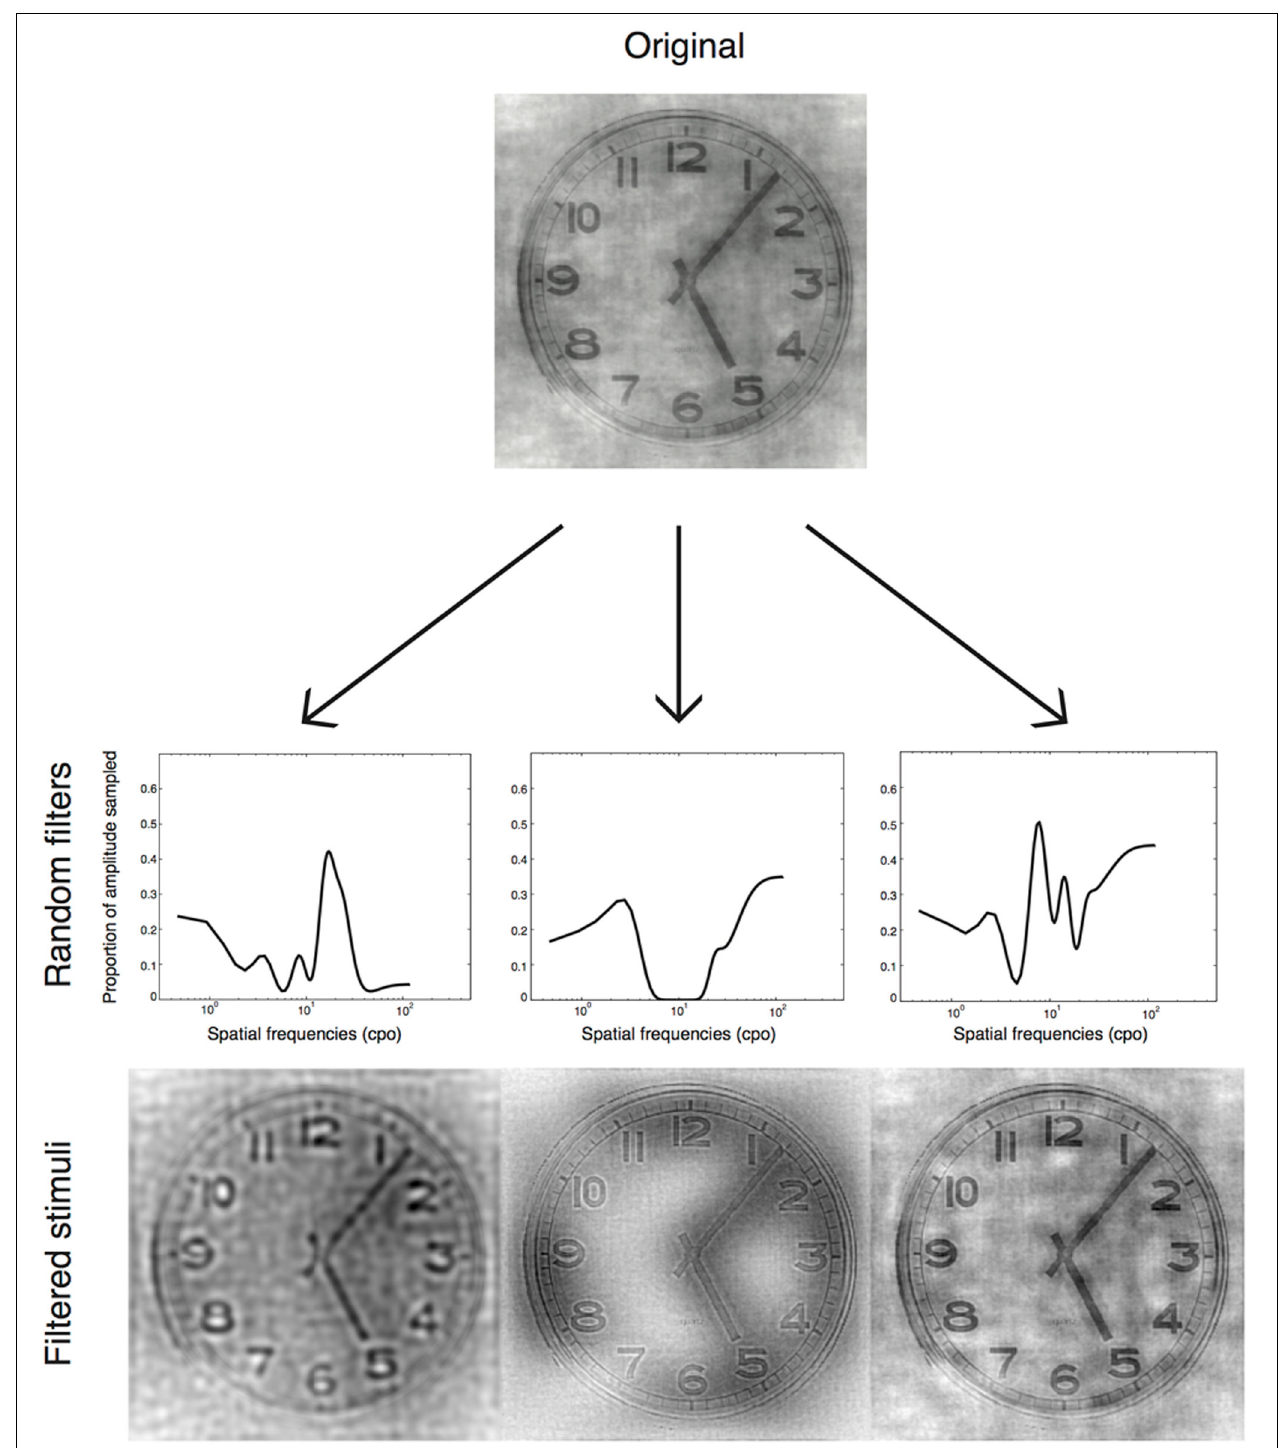
FIGURE 2 | Examples of stimuli presented in the experiment. These are generated by applying random filters to a base image.